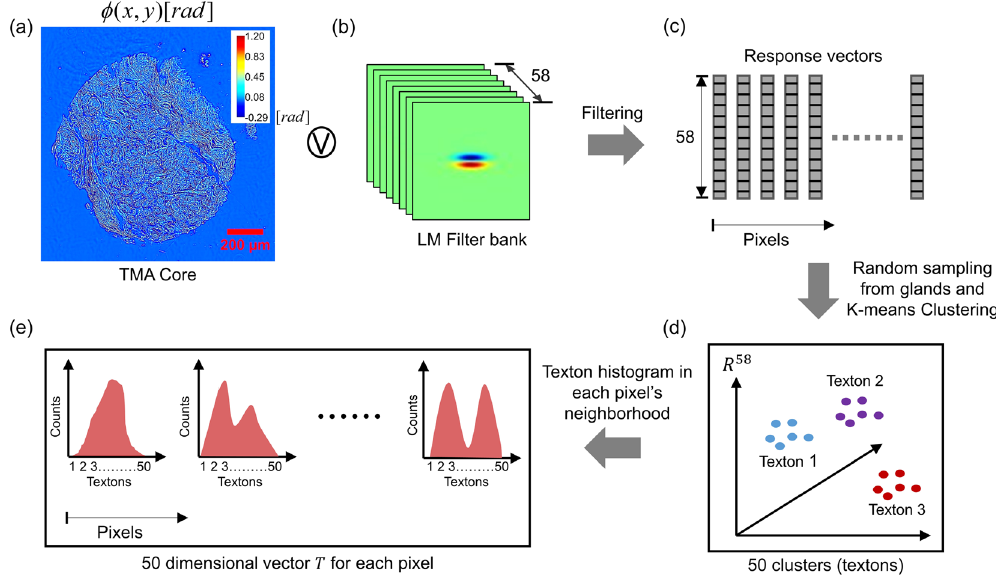
Figure 3. Algorithm for computing the texture in a pixel’s neighborhood. ( a – c ) Generating the response of each pixel to a Leung-Malik filter bank. ( d ) K-means clustering of response vectors, generated from all cores in the training set, in order to find 50 cluster centroids or textons. ( e ) Histogram of textons, within a pixel’s neighborhood, comprise the texture-related feature vector T for each pixel.